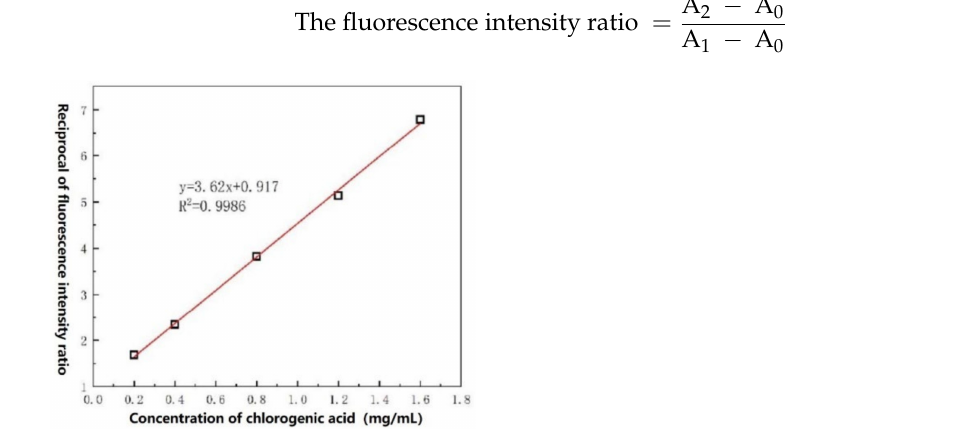
Figure 12. Fluorescence intensity ratio of CQDs after adding different concentrations of chlorogenic acid.